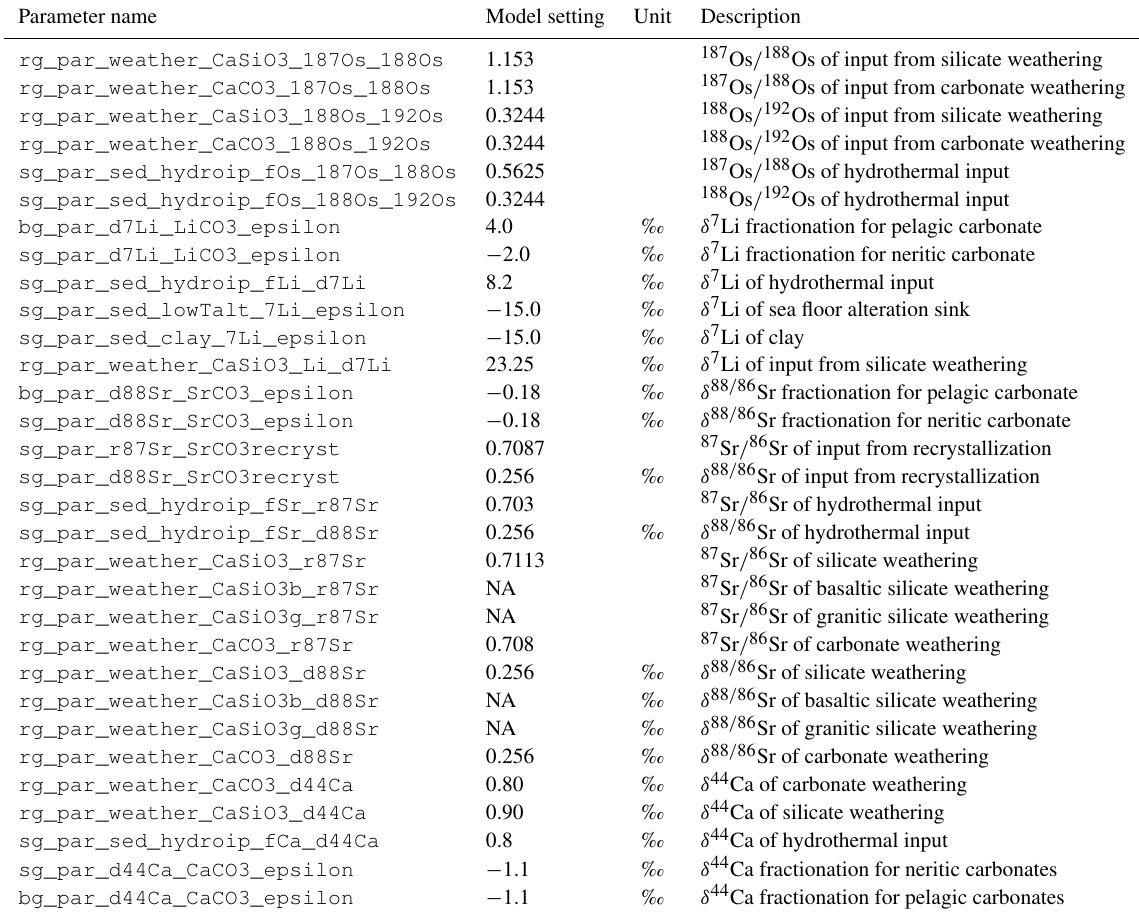
Table E8. Model parameters for the representation of isotopes and isotopic